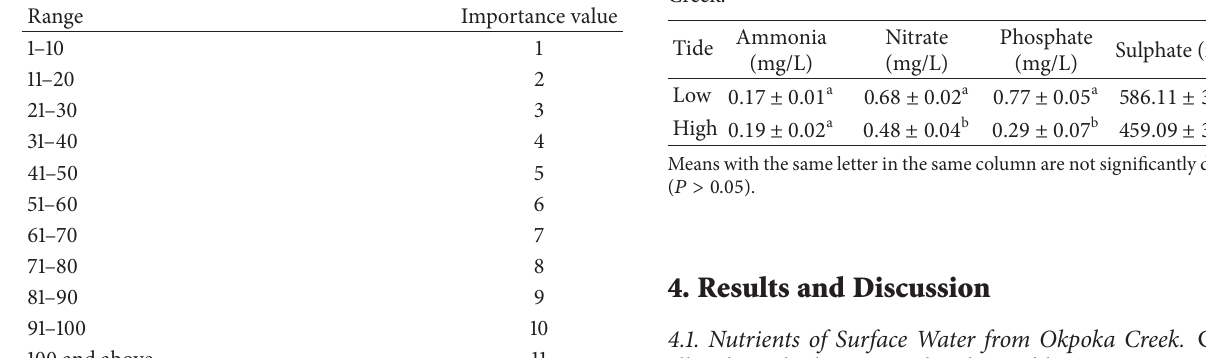
Table 1: Important values assigned to i th species abundance. Table 2: Variations of water nutrients in relation to tide in Okpoka